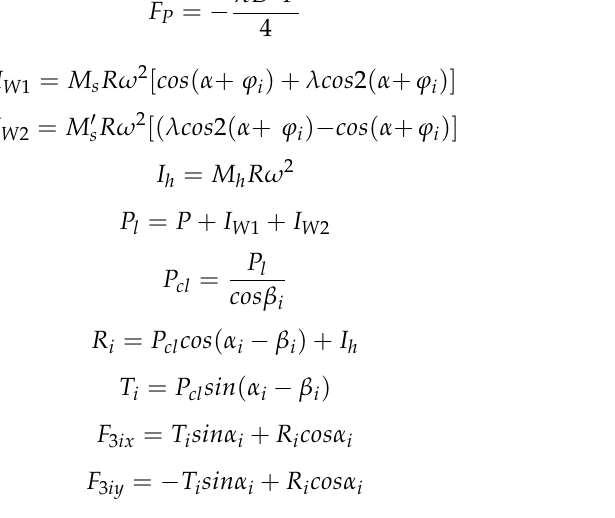
is α and the swing a ngle is β, the angular speed of the crank rotation is 𝜔 , and the dis-